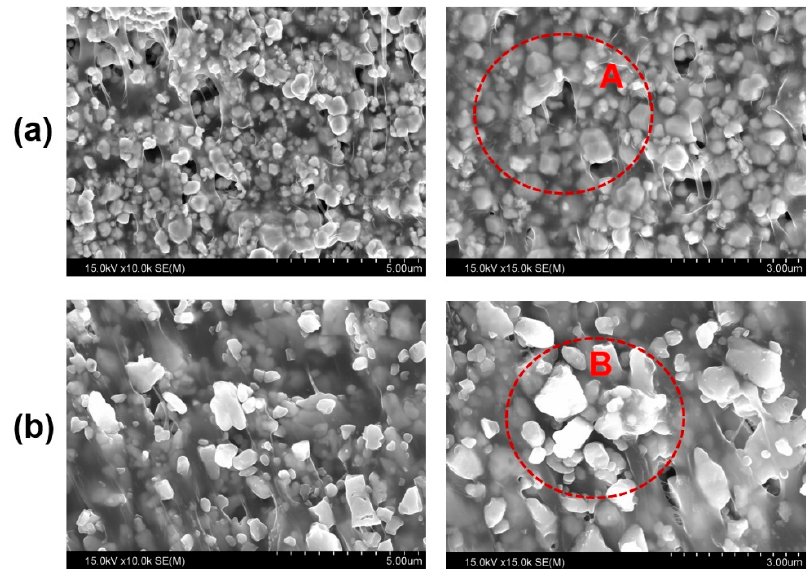
Figure 6. Comparative analysis of the cross-sectional images of single and composite materials of shield samples: ( a ) PW-85 (W) and ( b ) PWBaBi-80 (W, Ba, Bi). The circled portion labeled A exhibited the encapsulation phenomenon progressed by polymer coating around the particles of the shielding material, and B presents the state of the agglomeration between the particles of the composite material.